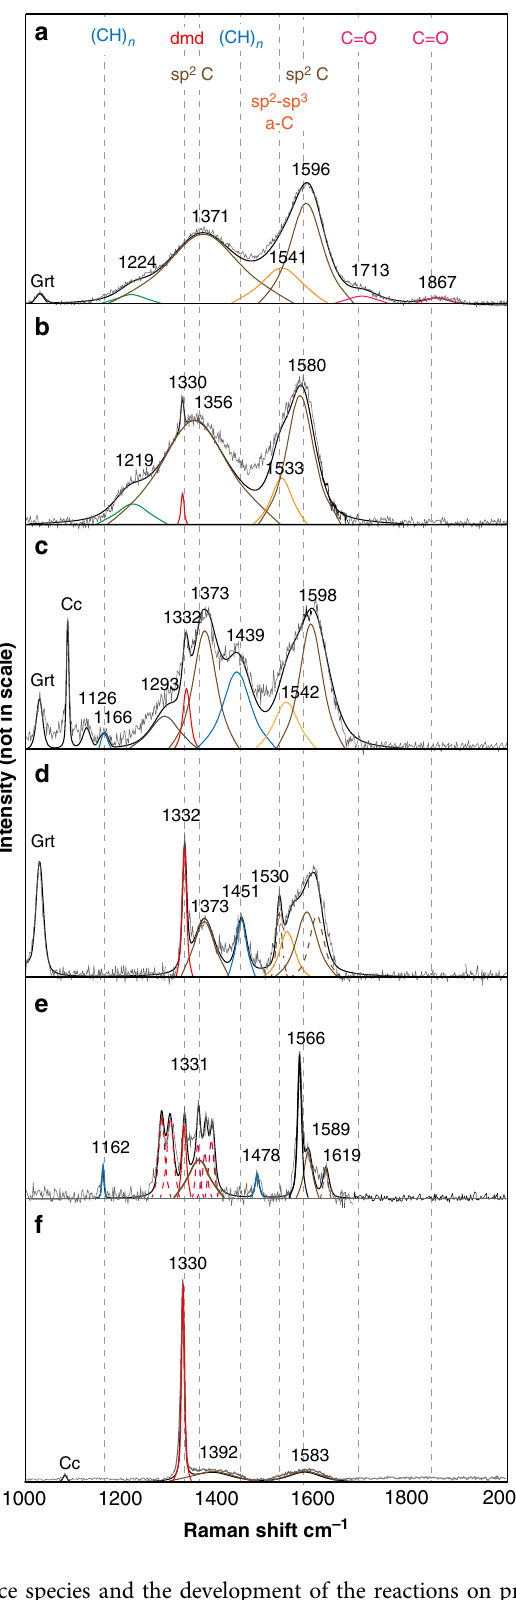
diamond surfaces. Previous studies reveal that nanodiamonds contain a large number of dangling carbon atoms at the surface, depending on surface characteristics, crystallographic faces, and density of impurities 36,37 . As a consequence, the surfaces are highly unstable and adsorb a variety of chemical groups (e.g.,